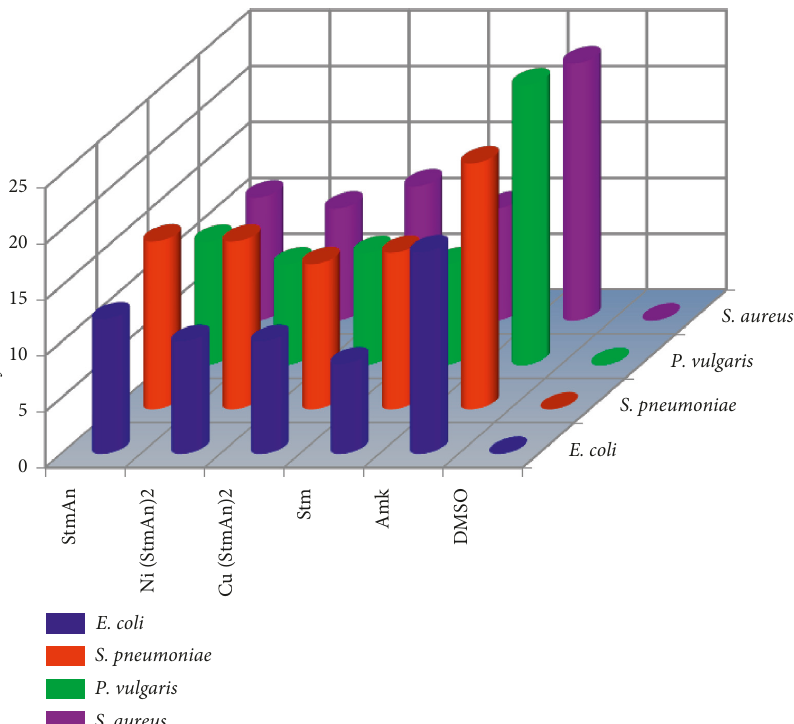
Figure 8: Bar graph showing the antibacterial activity at 25 μ g/ μ L